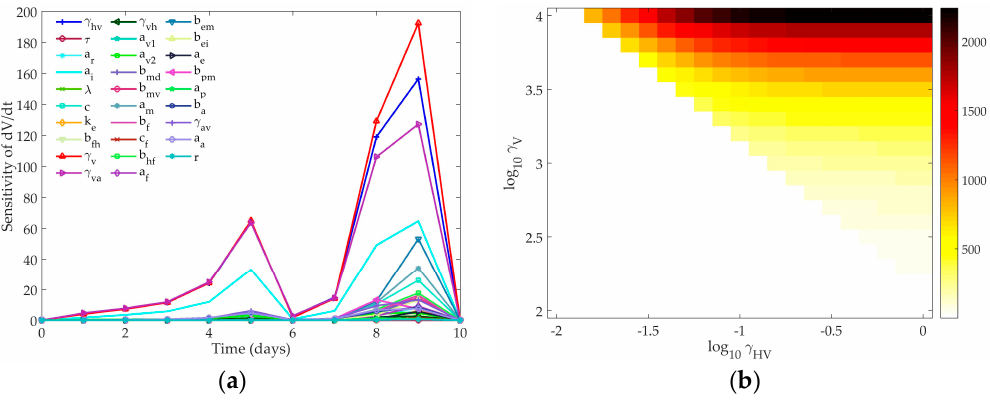
Figure 4 Figure 4. ( a ) Time-dependent sensitivity of virus to each parameter in the Hancioglu model; ( b ) Two-dimensional sensitivity of Hancioglu model to two most sensitive parameters: γ VH and γ V . Colors correspond to the maximum amount of virus present over a ten-day simulation. White indicates that the maximum value of V is 0.01, the initial value of the virus. Darker colors indicate higher values of peak